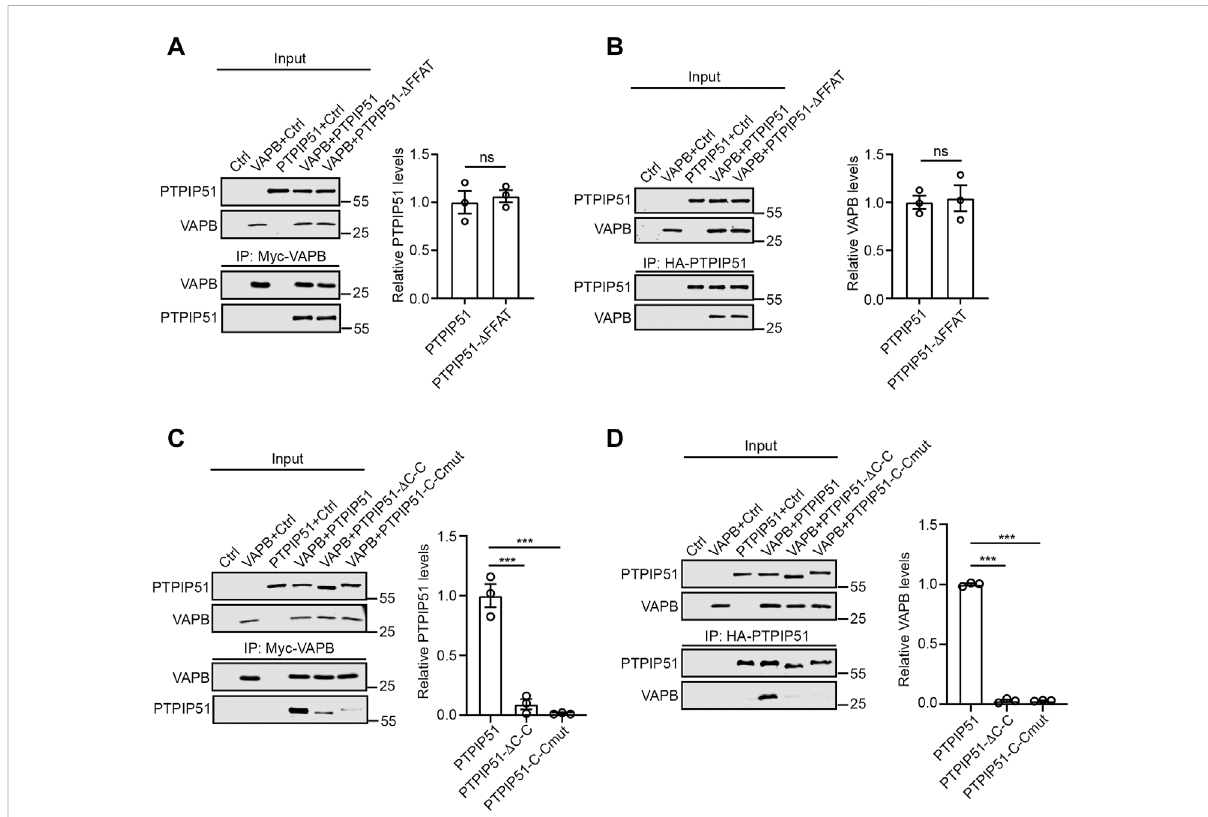
The PTPIP51 coiled-coil domain but not the FFAT motif is required for binding to VAPB in immunoprecipitation assays. (A,B) , deletion of the FFAT motif does not affect PTPIP51 binding to VAPB. HEK293 cells were transfected with control empty vector (Ctrl), myc-VAPB plus Ctrl, PTPIP51- HA plus Ctrl, myc-VAPB plus PTPIP51-HA or myc-VAPB plus PTPIP51- Δ FFAT-HA in which the FFAT motif was deleted. VAPB (A) or PTPIP51 (B) were immunoprecipitated using the myc- and HA-tags respectively and the amounts of bound PTPIP51-HA or myc-VAPB detected by immunoblotting using HA and myc antibodies. (C,D) , deletion and mutation of the PTPIP51 coiled-coil domain markedly disrupt binding to VAPB. Cells were transfected with control vector (Ctrl), myc-VAPB plus Ctrl, PTPIP51-HA plus Ctrl, myc-VAPB plus PTPIP51-HA, myc-VAPB plus PTPIP51- Δ C-C-HAormyc-VAPBplusPTPIP51-C-Cmut-HA.VAPB (C) orPTPIP51 (D) wereimmunoprecipitatedusingthemyc-andHA-tagsrespectivelyand the amounts of bound PTPIP51-HA or myc-VAPB detected by immunoblotting using HA and myc antibodies. No signals were obtained for bound PTPIP51 (A,C) or VAPB (B,D) in immunoprecipitations from control-transfected cells or in cells transfected with myc-VAPB or PTPIP51-HA alone which demonstrates the speci fi city of the assays. Both inputs and immunoprecipitations (IP) are shown in A-D. Bar charts show the relative level